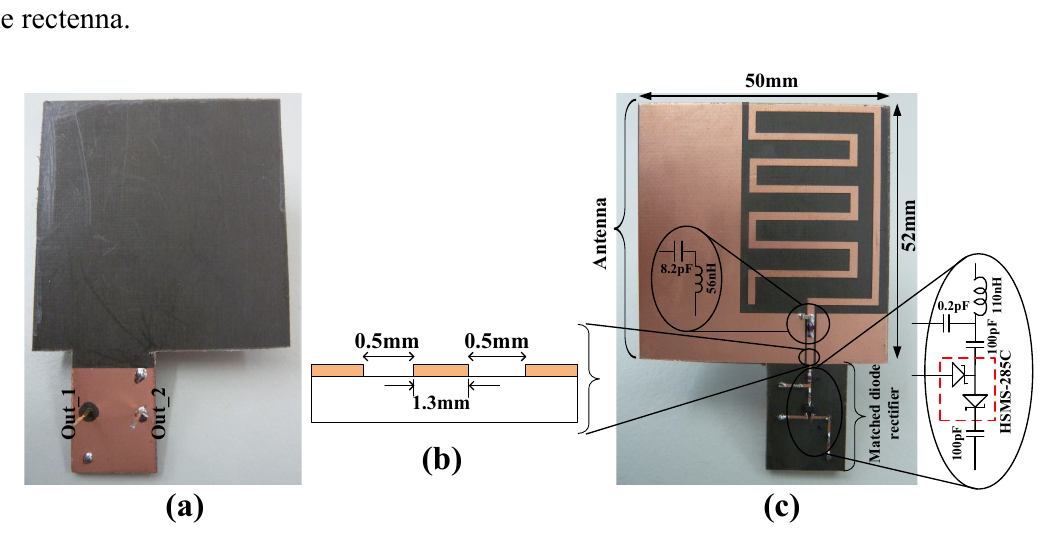
Figure 17. Rectenna realized on a Duroid 5880, 1.57 mm substrate. ( a ) Backside of the rectenna, ( b ) cross-section of antenna output coplanar stripline dimensions ( c ) frontside of the